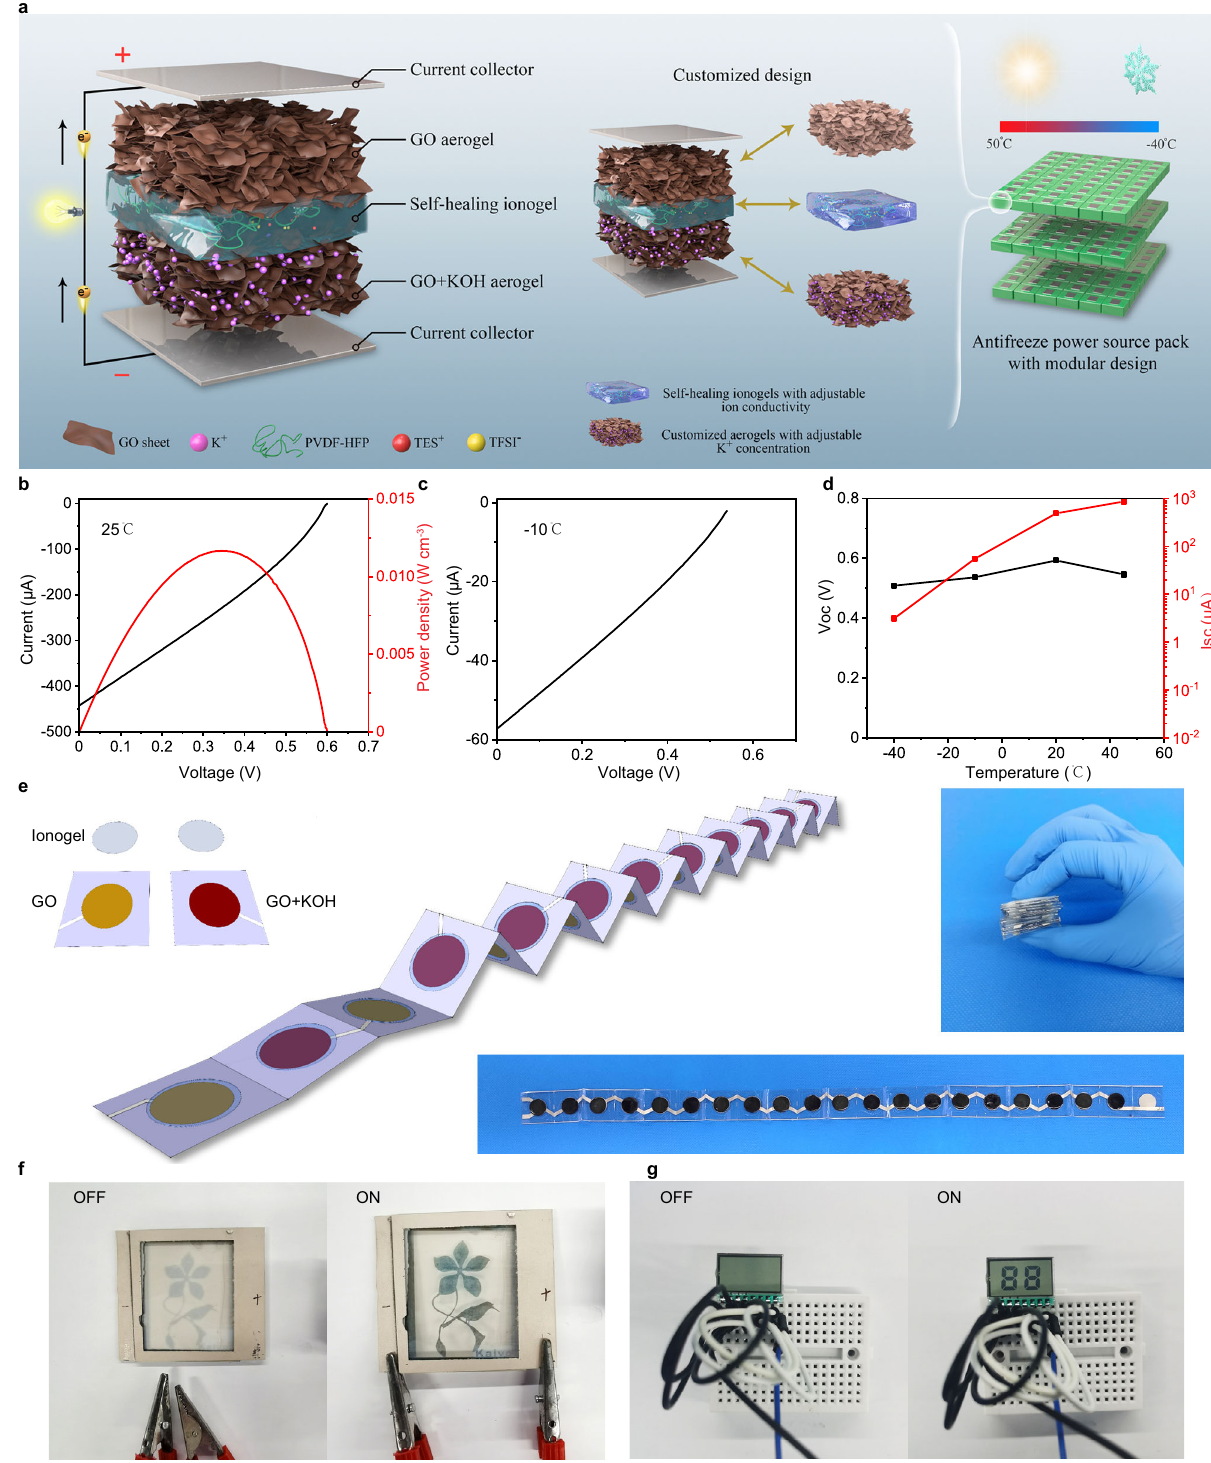
Fig. 4 | Modular design osmotic power source. a Schematic illustration of the modular design device construction. Two GO aerogels with different K + con- centrationsaresandwichedbetweenchargecollectorsandseparatedbyanionogel that consists of RTIL (TESTFSI) and PVDF-HFP polymer matrix. b I – V characteristic and power density of the GO aerogel-based power source with ionogel electrolyte at 25°C. c I – V characteristic of the power source at − 10°C. d The output